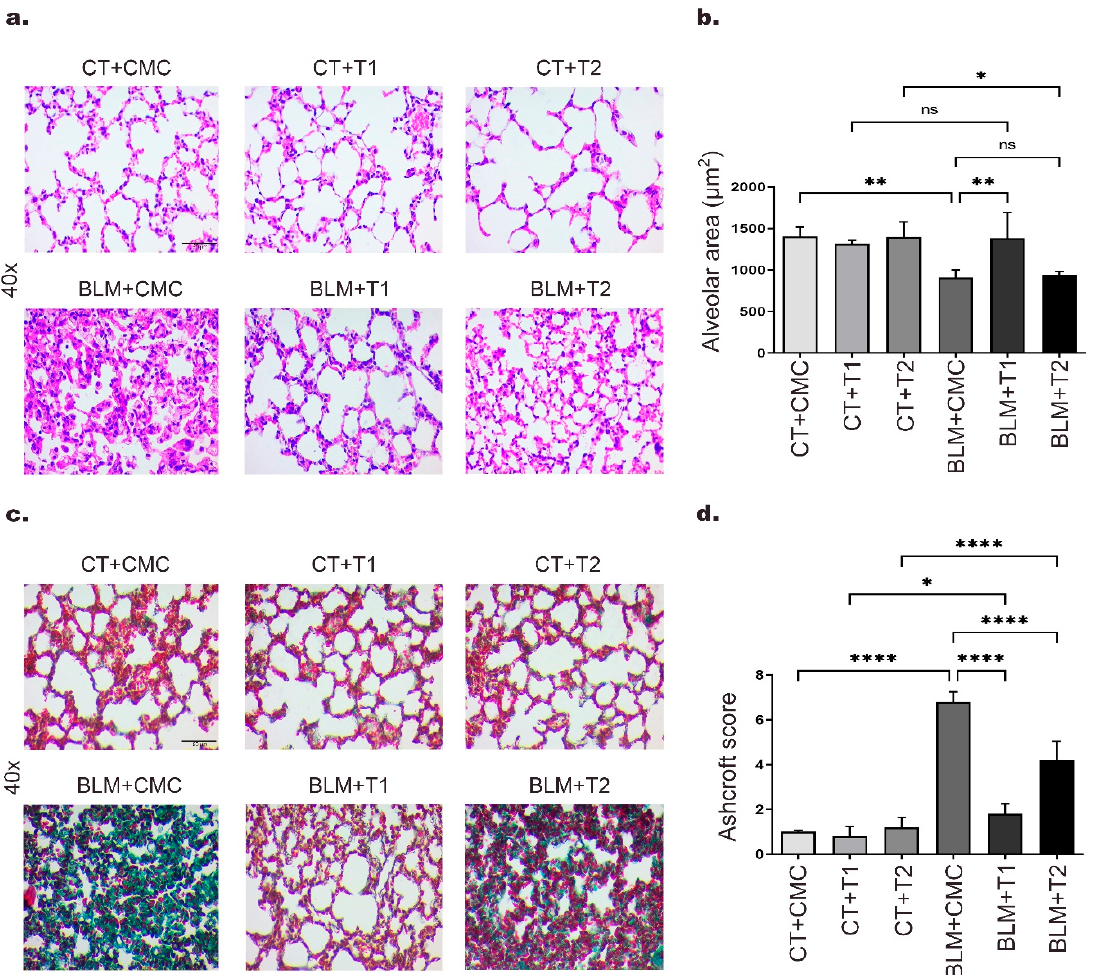
Figure 1. 3 ′ 5-DMBA attenuates BLM-induced pulmonary fibrosis in mice. Mice in BLM groups were instilled with an osmotic minipump loaded with BLM 100 U/kg. Mice in control groups (CT) have a sham instillation. On day 14, mice received either 3 ′ 5-DMBA or its vehicle intragastrically until they were euthanized on day 28. ( a ) Sections of lung tissue stained with H&E; ( b ) bar graph showing H&E staining analysis of alveolar area size made using ImageJ software; ( c ) Masson’s trichrome staining of lung tissue showing collagen fibers in green; ( d ) Bar graph showing the Ashcroft scale score for all groups. CT+CMC: control group, BLM+CMC: BLM-treated group, BLM+T1: BLM plus 3 ′ 5-DMBA-treated group at a dose of 6 mg/kg, and BLM+T2: BLM plus 3 ′ 5-DMBA-treated group at a dose of 10 mg/kg. Representative images were taken at 40× magnification. Scale bar = 50 μ m. Data are represented as the mean ± SD ( n = 4). Data were analyzed by one-way ANOVA followed by Tukey’s t -test for comparison between groups. For each graph, the asterisks above the horizontal lines indicate significant differences with respect to their control groups and differences between the two doses and the vehicle. * p < 0.05, ** p < 0.01, and **** p < 0.0001. BLM: bleomycin, CMC: